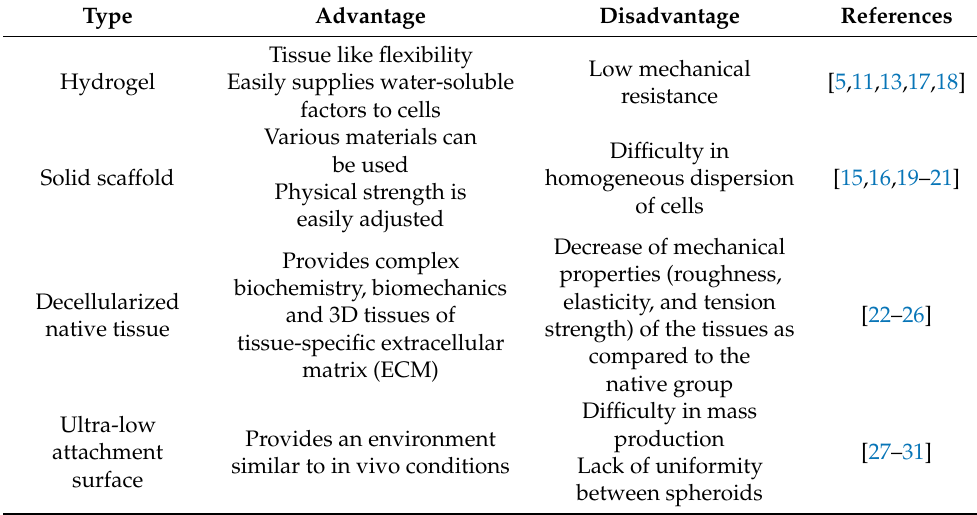
Table 1. Types of biomaterials used in three-dimensional (3D) cell culture and their advantages and